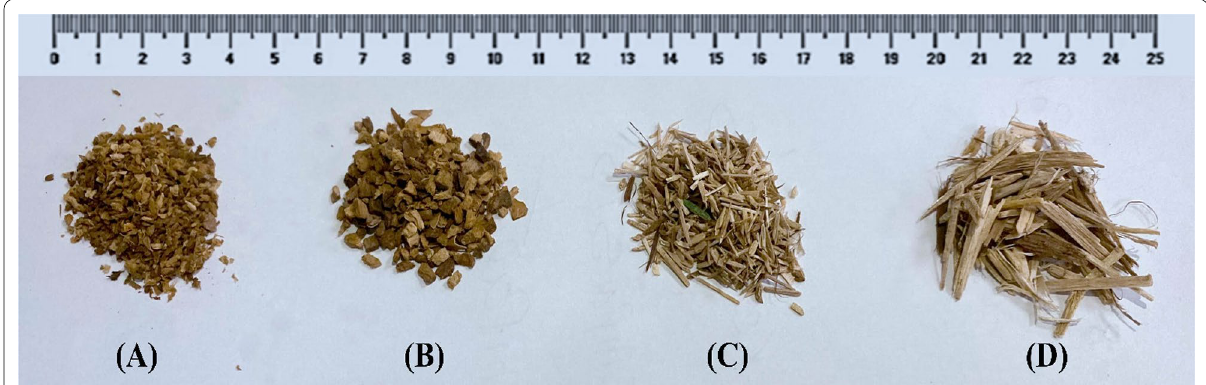
Fig. 1 Digital image of TOCS and wood particles sieved with different ASTM mesh size, ( A ): TOCS Wood